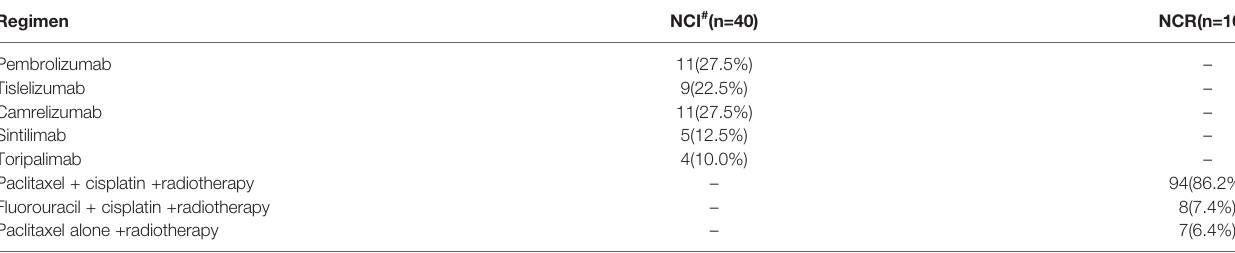
TABLE 2 | The regimens of neoadjuvant treatments.